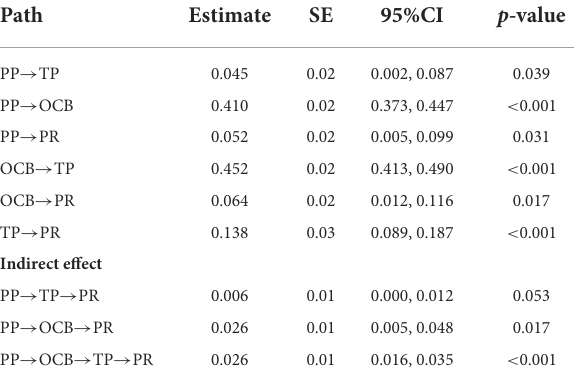
TABLE 3 Path coefficient for proactive personality and promotion.